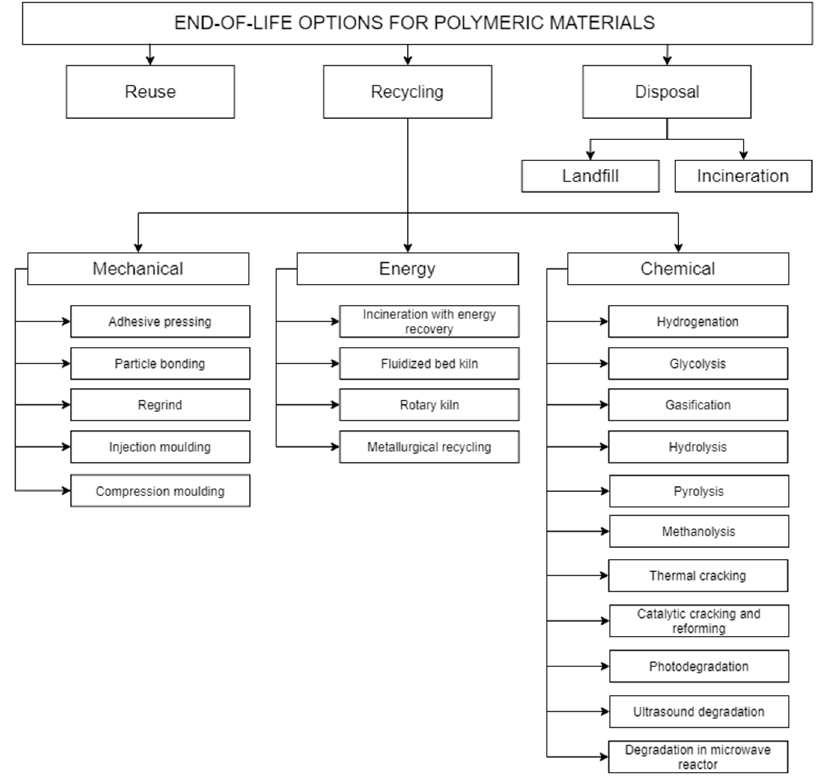
Figure 2. End-of-life options for contaminated, structurally changed plastic waste. Own work based on data from [62–69].